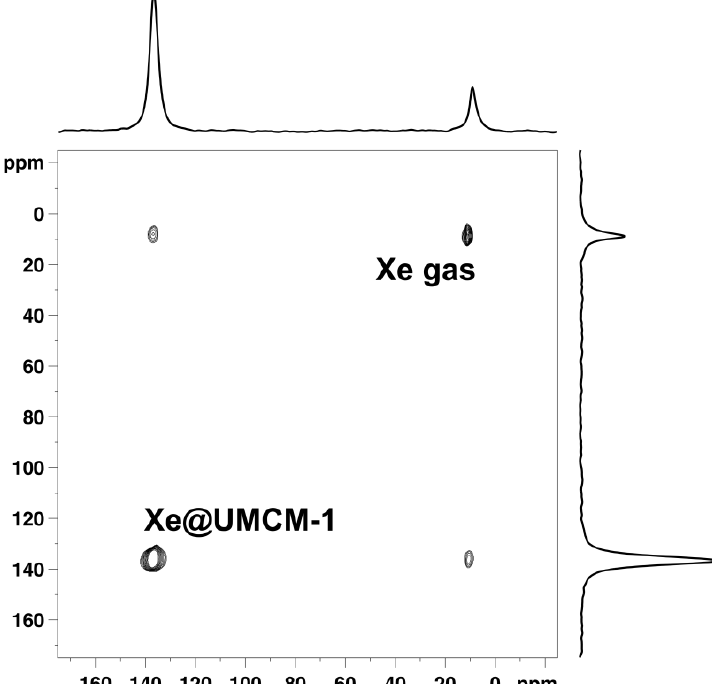
Figure 12. 2D 129 Xe EXSY spectrum of Xe adsorbed on UMCM-1 measured at RT and 70 ms mixing